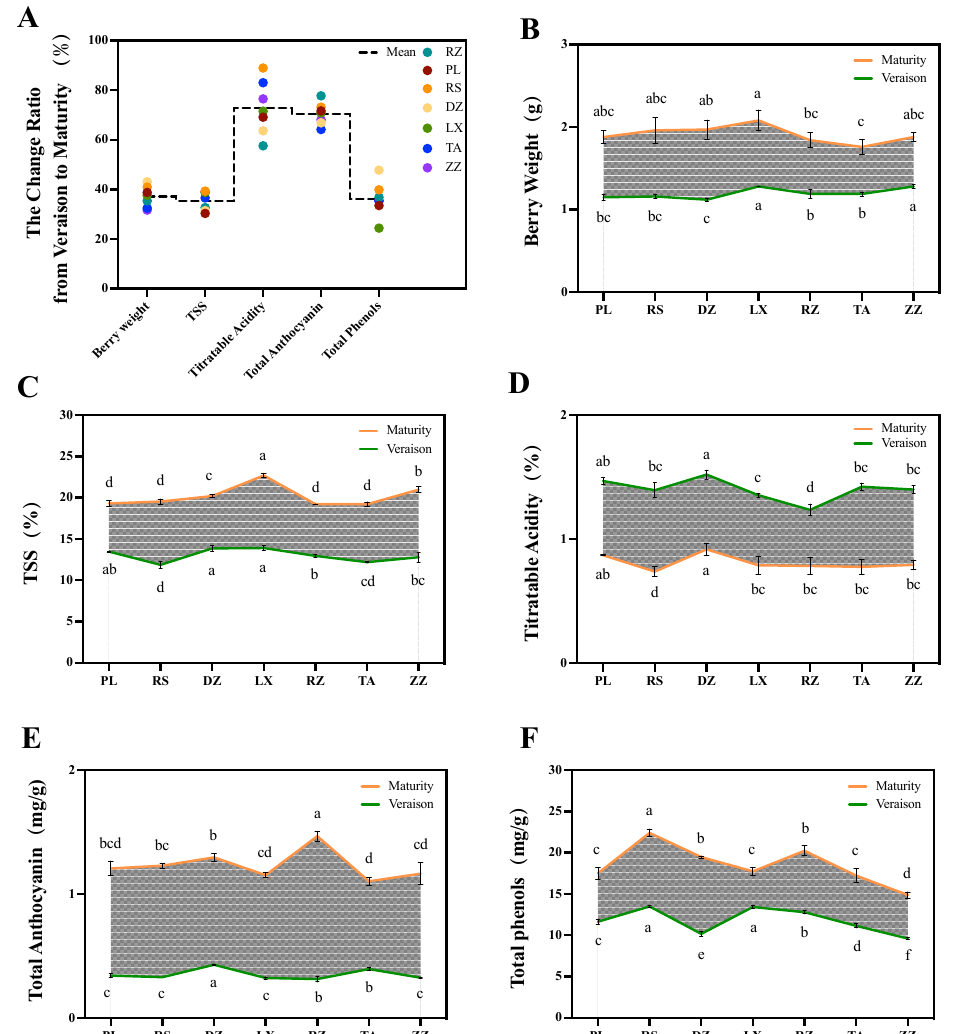
Figure 2. The change ratio of five quality indices during half-v é raison and maturity stages in grape berries belonging to different regions. Variance ratio ( A ) and changes of five quality indices including berry weight ( B ), TSS ( C ), titratable acids ( D ), anthocyanins ( E ), and total phenolics ( F ) between half-v é raison and maturity stages of grape berries. The broken line represents the quality indices in seven regions including DZ, LX, PL, RZ, RS, TA, and ZZ. The green and orange lines represent the change in different regions in the half-v é raison and maturity stages. The different letters indicate the significant differences between regions ( p ≤ 0.05) using Duncan’s test. Experiments were performed using three